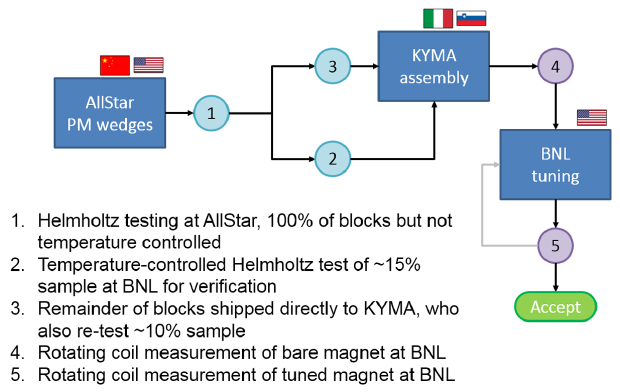
FIG. 8. Production and testing flow.